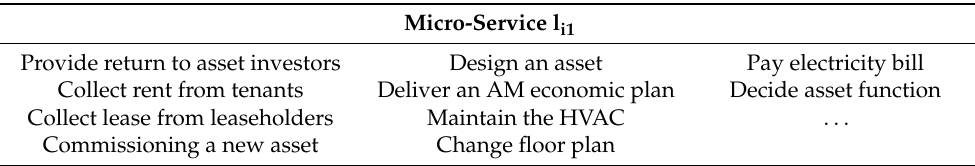
Table 2. Asset Omni-management model—microservices.